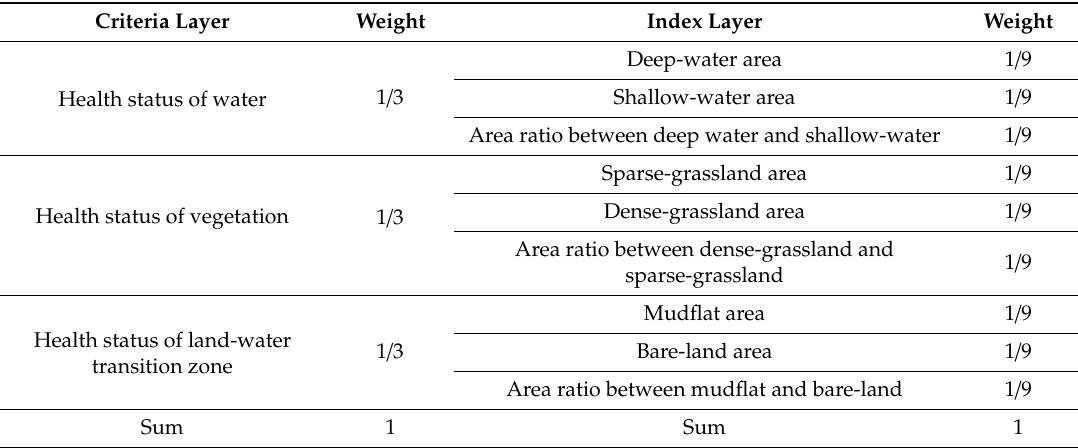
Table 2. Weight of each indicator in the evaluated index system.